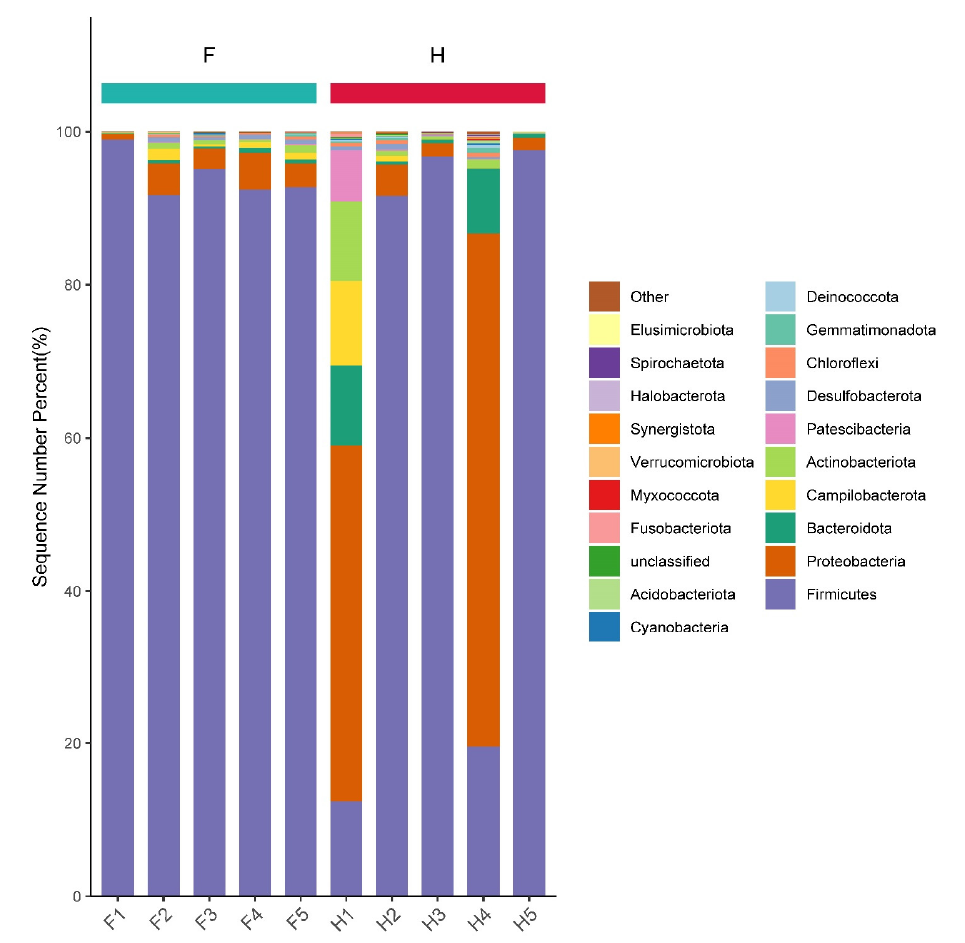
Figure 6. Proportion of different bacteria at the phylum level in the samples. F means factory production; H means household handmade.